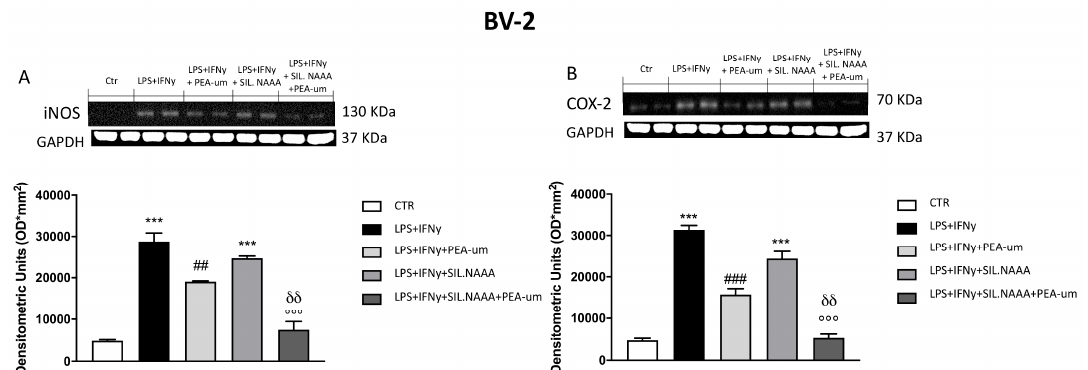
Figure 6. Effect of PEA-um treatment and NAAA-siRNA knockdown on the expression of iNOS, and COX-2 in BV-2 mouse microglial cells. The stimulation with LPS/INF- γ significantly increased iNOS and COX-2 expression, compared to control ( A,B ). Treatment with PEA-um at the concentration of 10 μ M significantly reduced these expressions ( A,B ). In NAAA-silenced cells, stimulated with LPS/INF- γ , the expression of iNOS and COX-2 significantly increased compared to a notably reduction following PEA-um treatment ( A , B ). Data are representative of at least three independent experiments. *** p < 0.001 versus Ctr; ## p < 0.01 and ### p < 0.001 versus LPS/INF- γ ; °°° p < 0.001 versus LPS/INF- γ + silenced NAAA; δδ p < 0.01 versus LPS/INF- γ + NAAA silencing + PEA-um treatment.